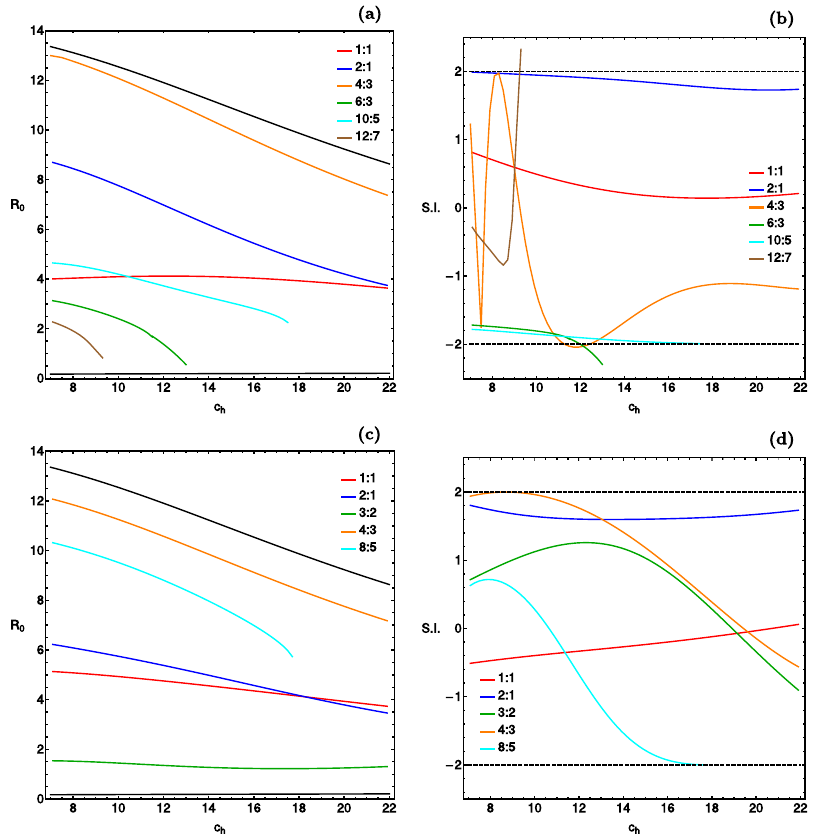
Fig. 8. Evolution of the R coordinate of periodic orbits as a function of the scale length of the halo, c h , for the PH models (panel a) and OH models (panel c), and the evolution of the stability index S.I. as a function of c h for the PH models (panel b) and OH models (panel d). c h = { 7 ; 8 : 5 ; 10 ; :::; 22 }